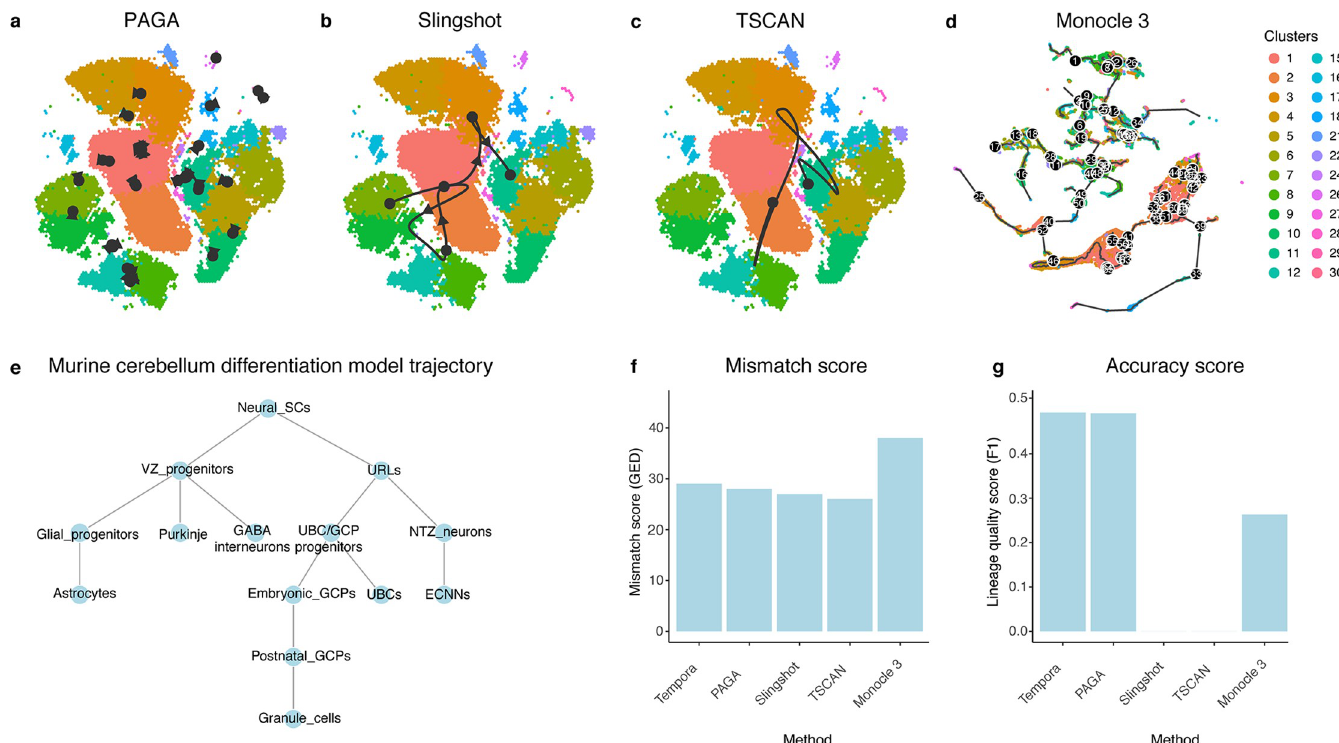
Fig 7. Performance evaluation on the murine cerebellar data set. a-e. Trajectories of the murine cerebellar data set inferred by a. TSCAN, b. PAGA, c. Slingshot, d. Monocle 3. e. The gold standard trajectory used to evaluate the accuracy of all inferred trajectories. f. Mismatch scores and g. accuracy scores of trajectories from the evaluated